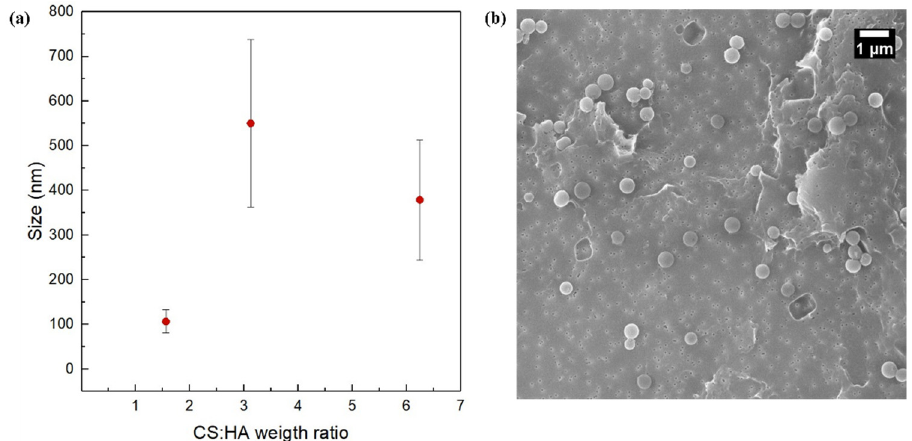
Figure 3. NPs’ size and morphology at different polymer ratios at low flow rate regime and FR 2 = 0.5: ( a ) Plot of NP size vs. CS:HA weight ratio; ( b ) representative SEM image at CS: HA weight ratio equal to 3.12.